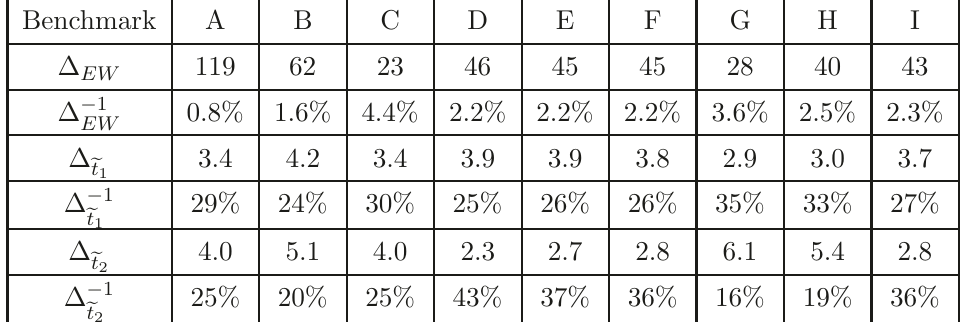
Table 3 . Electroweak fine-tuning measures ∆ EW and ∆ e for the -SU(5) D-brane inspired t 1 , 2 F naturalness region. The fine-tuning percentage is found via ∆ − 1 , also provided here. Those points with ∆ EW < 30 are regarded as low electroweak fine-tuning. Note that the fine-tuning for only the top squarks, represented by ∆ e , is of t 1 , 2 O